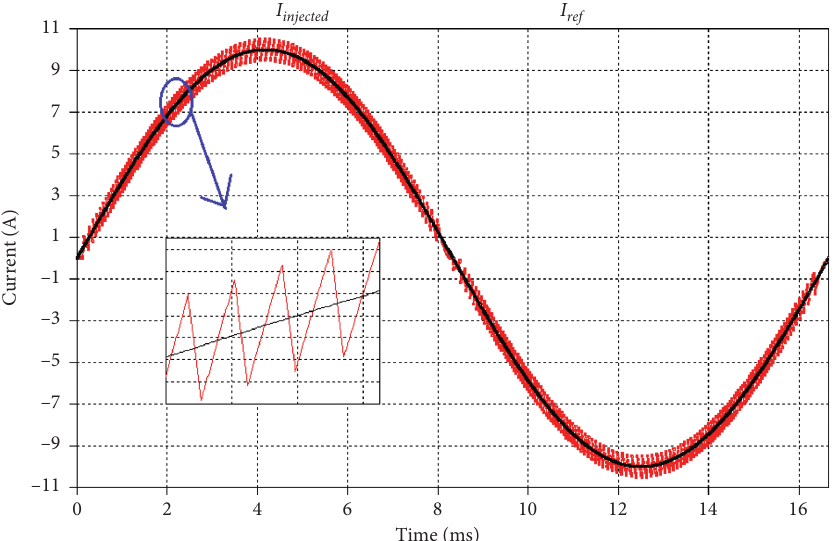
Figure 4: Evolution of the injected current (magenta) into the grid and its reference (blue).